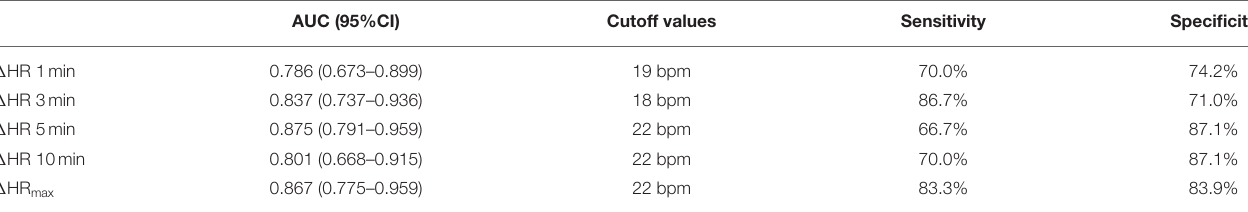
TABLE 3 | Optimal 1 HR at different time intervals during the sitting test for prediction of orthostatic